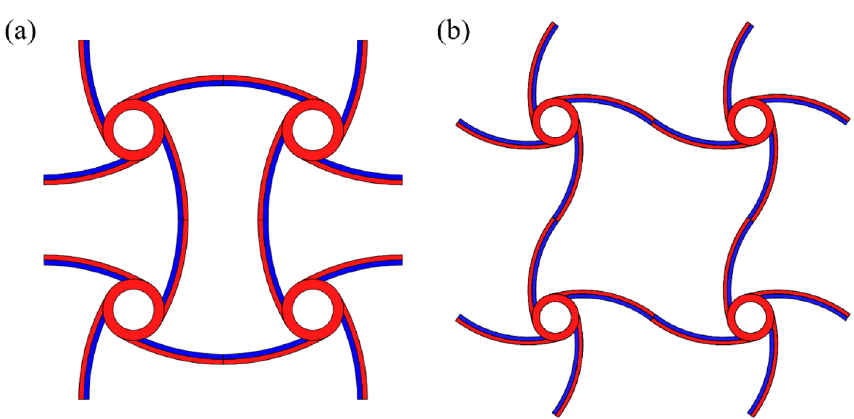
Figure 10. Two novel NTE metamaterials: ( a ) anti-tetra chiral structure; ( b ) tetra chiral